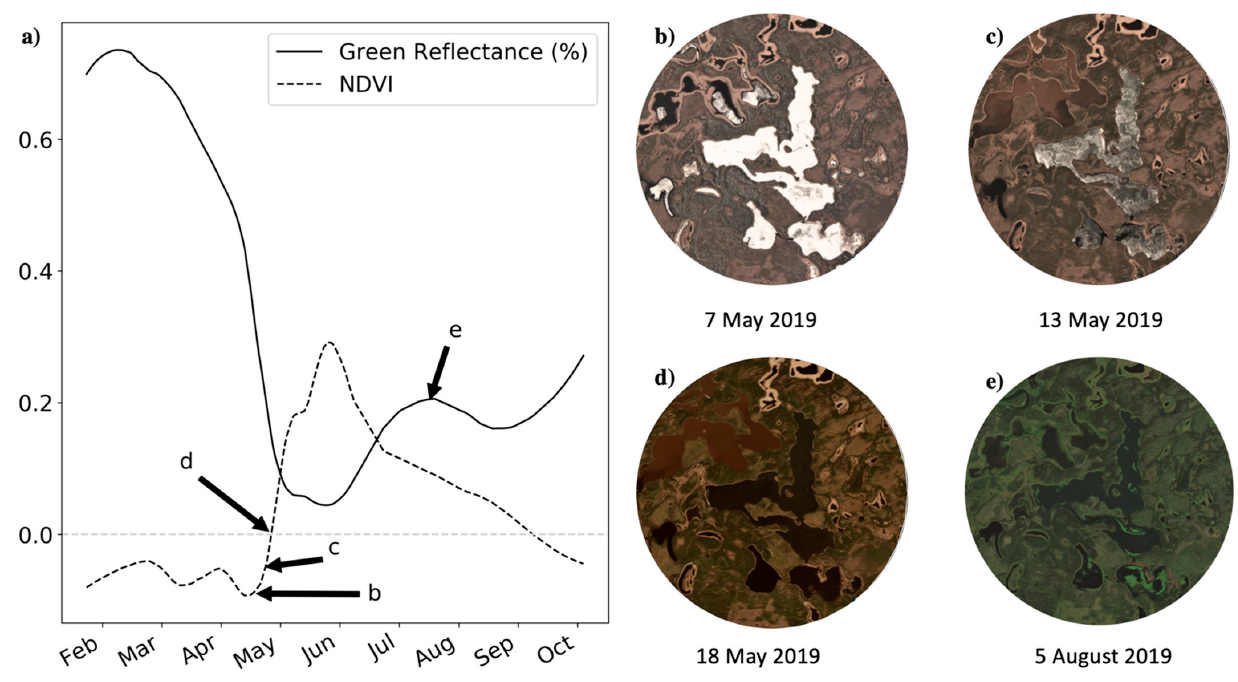
Figure 3. ( a ) Smoothed time series of NDVI and green reflectance for an example lake, Scoter Lake, AK, in 2019. Arrows indicate dates of PlanetScope scenes shown on right where each arrow corresponds to the PlanetScope scene acquired on ( b ) May 7, ice-covered ( c ) May 13, partially ice-covered ( d ) May 18, full ice-out and ( e ) August 5, green-up. Images copyright Planet Labs (2021).